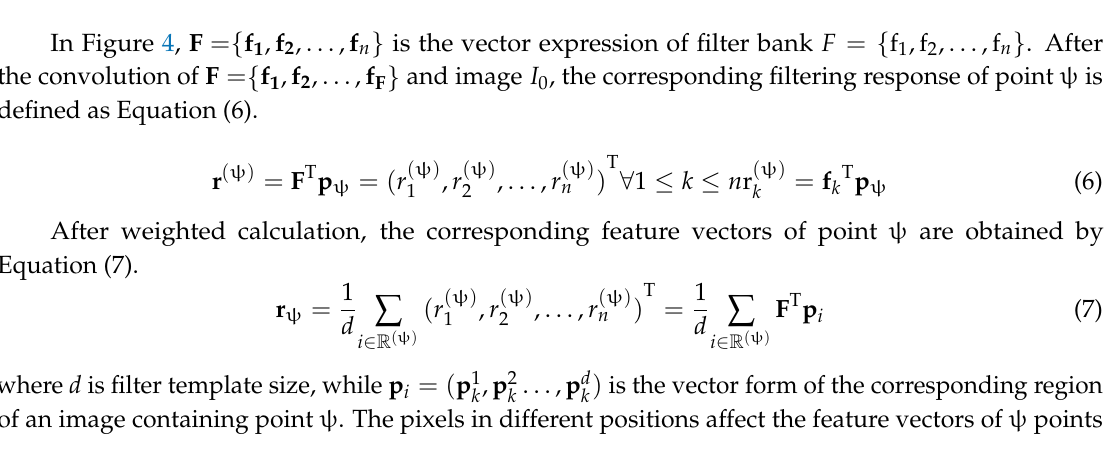
Figure 4. Adaptive filter bank construction. Filter banks are convolved with input image I 0 , to generate low-level feature ψ .